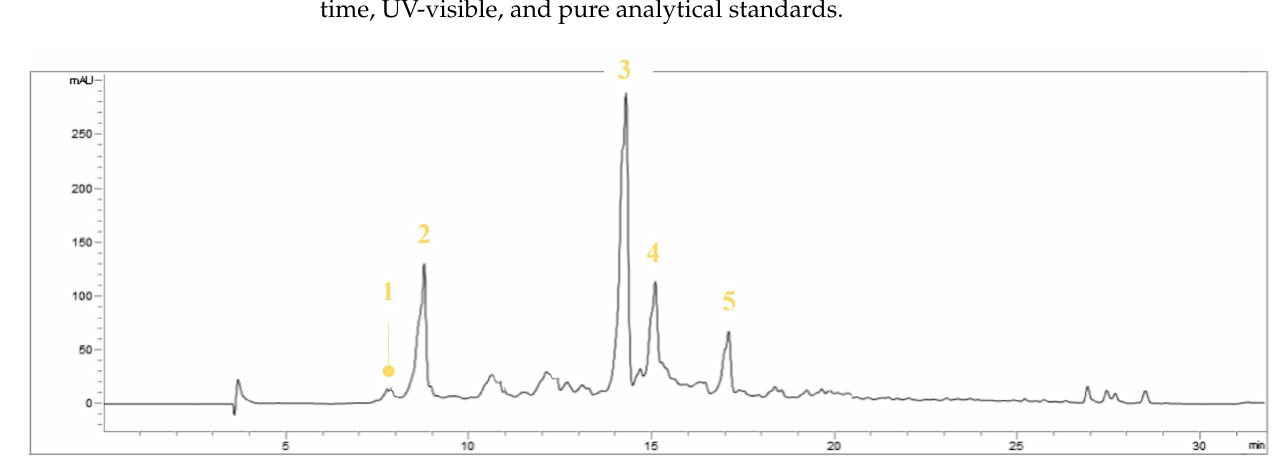
Figure 1. HPLC-UV recorded chromatogram at 280 nm of EVOOE. Compounds were numbered, based on their increasing retention time, as follow: hydroxytyrosol (compound 1), tyrosol (compound 2), oleocanthal (compound 3), oleuropein aglycone (compound 4), and ligstroside aglycone (compound 5).